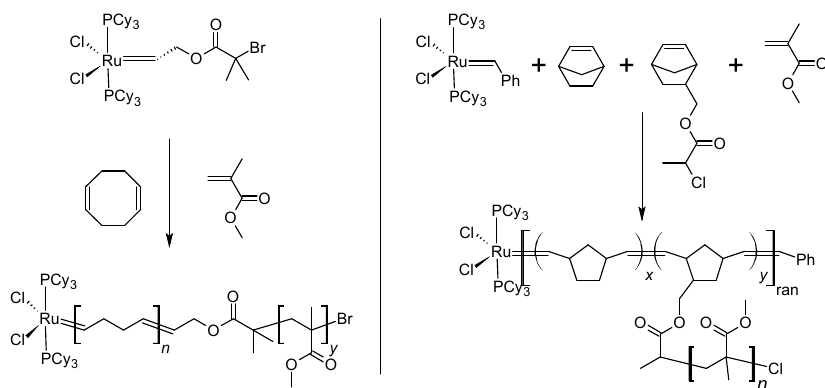
Figure 4. Synthesis of ( left ) diblock and ( right ) graft copolymer by concurrent ATRP and ring-opening metathesis polymerization (ROMP)